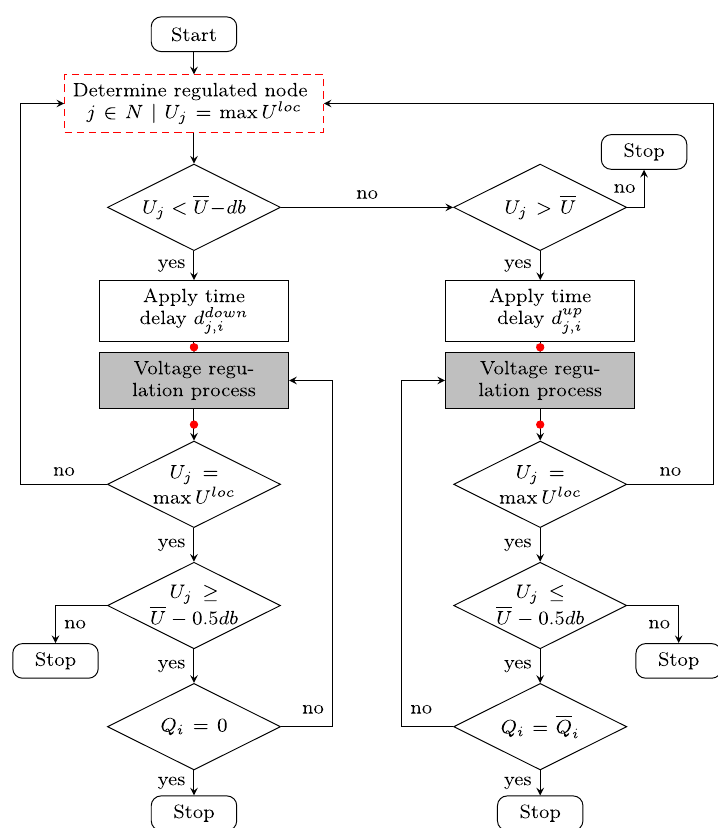
Fig. 1 Reactive power control scheme at DRES i according to Kryonidis et al. (2021). The Proportional Integral (PI) controller is part of the gray shaded voltage regulation process box. Note, that determination of the maximum voltage node (red dashed box) is also required after the delay time has elapsed and after the voltage regulation process (red dots on the